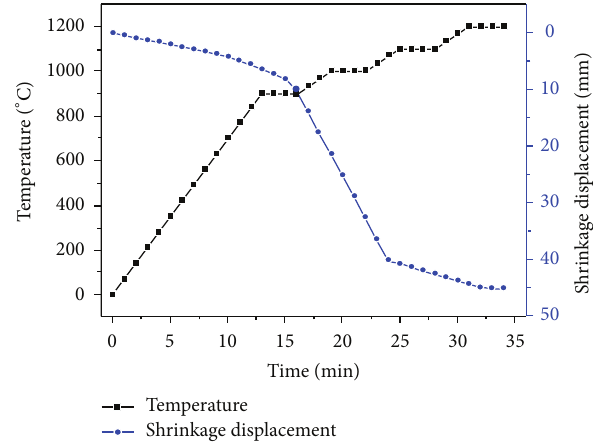
Figure 2: Variations of temperature and shrinkage as a function of heating time during spark plasma sintering of WC-3 wt% Co